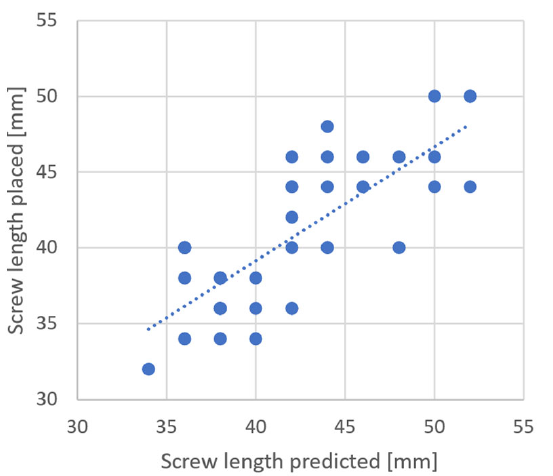
Figure 7. Correlation between Xin1 computed screw lengths (before screw placement) and actually placed screw lengths (no system output provided to the surgeon). Maximum plate offset before screw placement was 5 mm in a dorsal–ventral direction and 9 mm in a cranial–caudal direction in respect to the center of the humeral head. After placing the screws, the relative plate position shifted at a maximum of 4 mm for five out of six patients. In one patient (#10), the plate was displaced by 10 mm in the dorsal–ventral direction after screw placement according to the Xin1 measurement (Table 1). Table 1. Patient details, view angle of image pairs and plate position before (pre) and after (post) screw placement for the 6 patients undergoing retrospective image evaluation. D–V: dorsal–ventral plate position; negative sign: head center is located ventral from plate. C-C: cranial-caudal plate position; negative sign: head center is located caudal from plate. f: female, m: male; L: left, R: right.